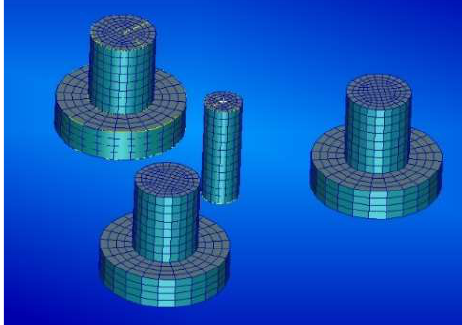
Figure 9. Platform modeling for the hydrodynamic analysis.